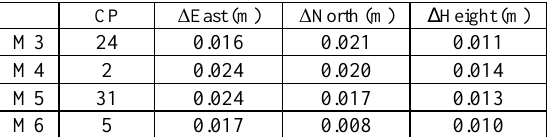
Table 4. Averages of the absolute values of the differences between the coordinates of the Control points determined by total station and those obtained by photogrammetry.